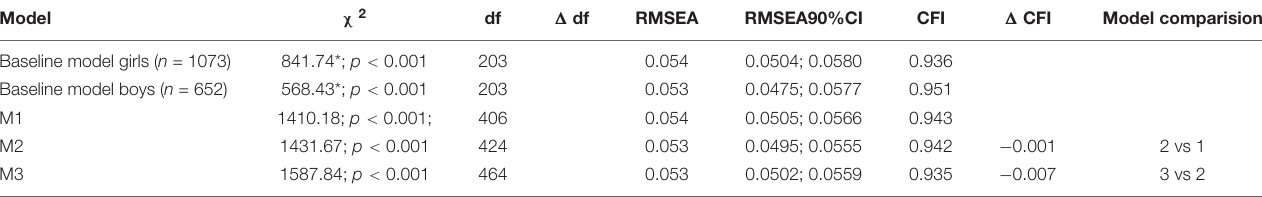
TABLE 4 | Measurement invariance.